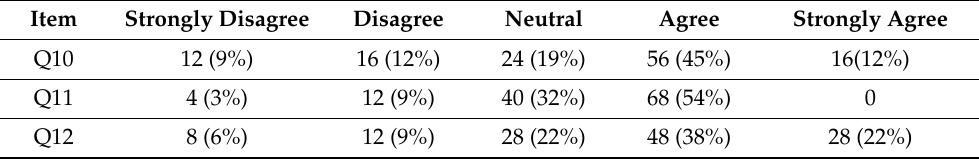
Table 11. Frequency distribution table for items regarding user interest in emotional